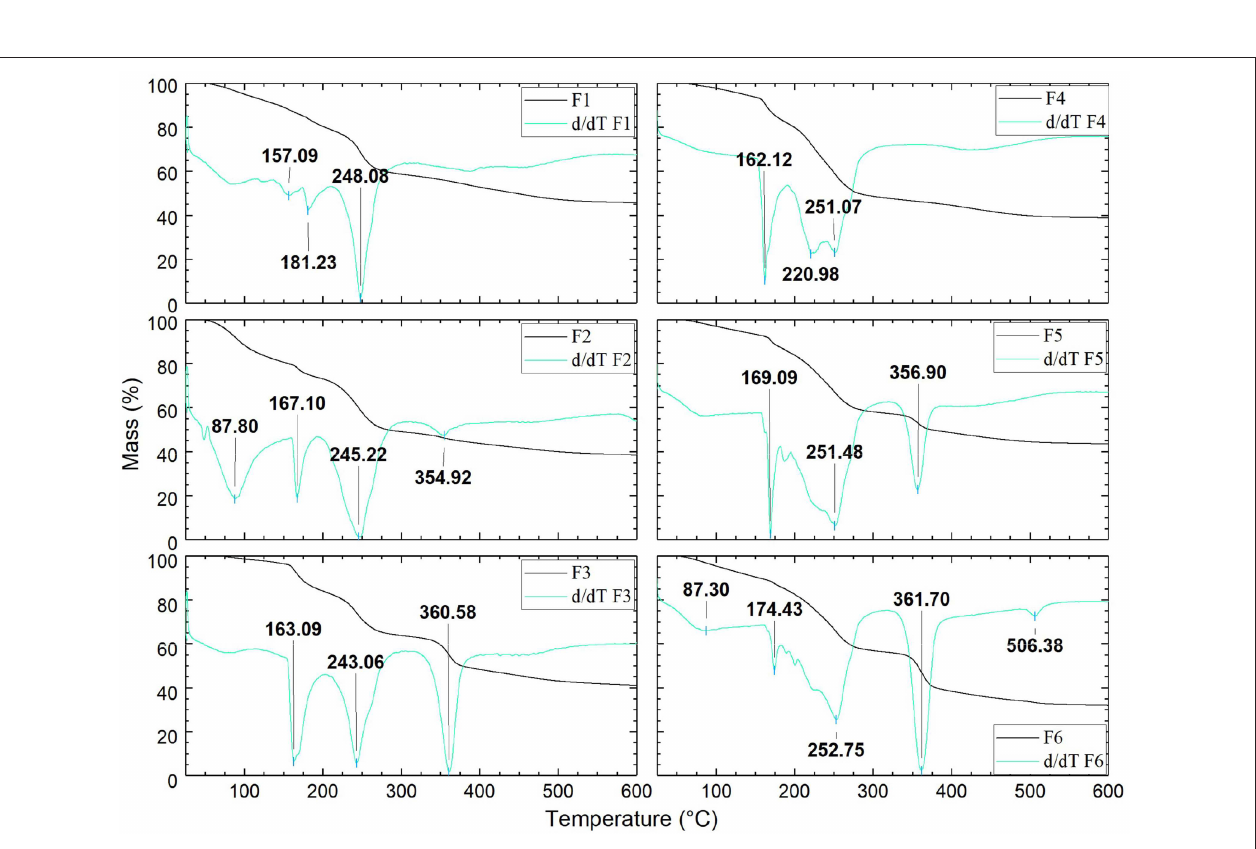
Frontiers in Mechanical Engineering |